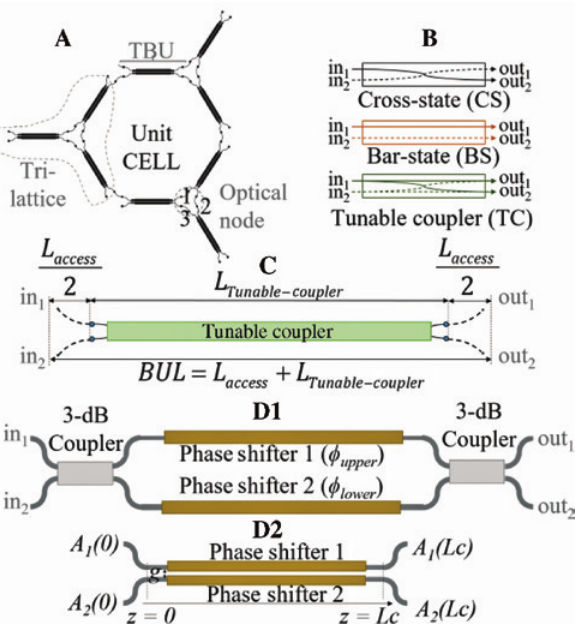
Figure 2: Single hexagonal cell implemented using three trilattices and alternatives for the tunable coupler unit. (A) Hexagonal unit cell. (B) Signal flow for the different TBU configu- rations. (C) Schematic of a general tunable coupler acting as the basic building block of the mesh: tunable basic unit (TBU). The basic unit length is illustrated as the sum of the tunable coupler length and the arc length of the access waveguides. A particular case of a tunable coupler implemented by (D1) a MZI and (D2) an integrated dual-drive tunable directional